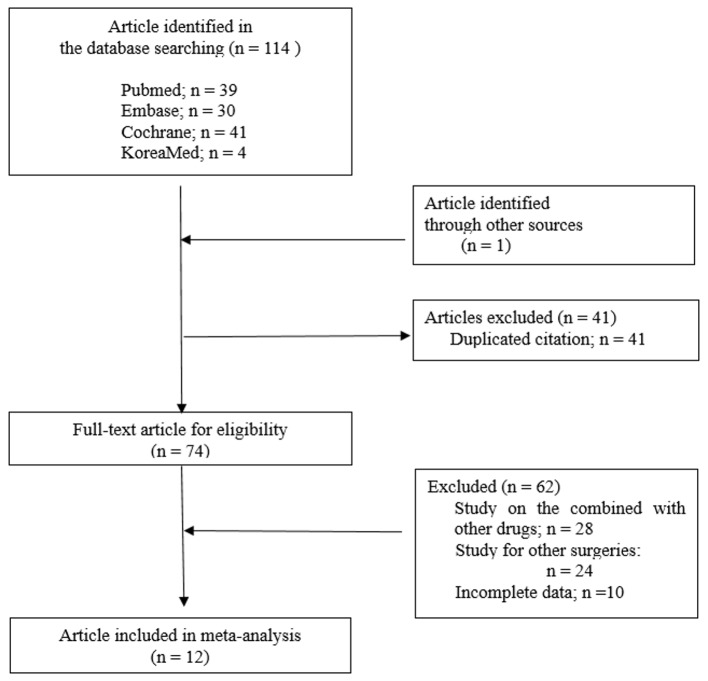
PRISMA flow diagram for the study inclusion and exclusion process.